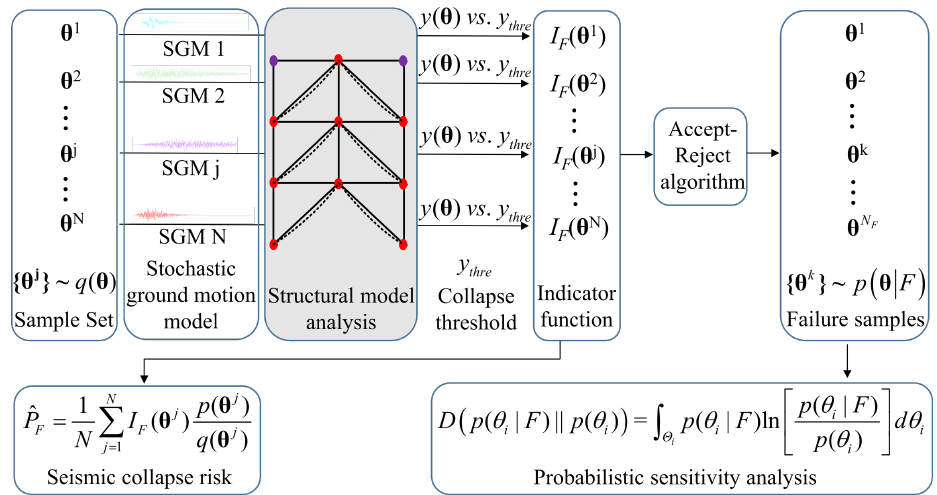
Figure 3. Flowchart for simulation based approach for seismic collapse risk assessment and proba- bilistic sensitivity